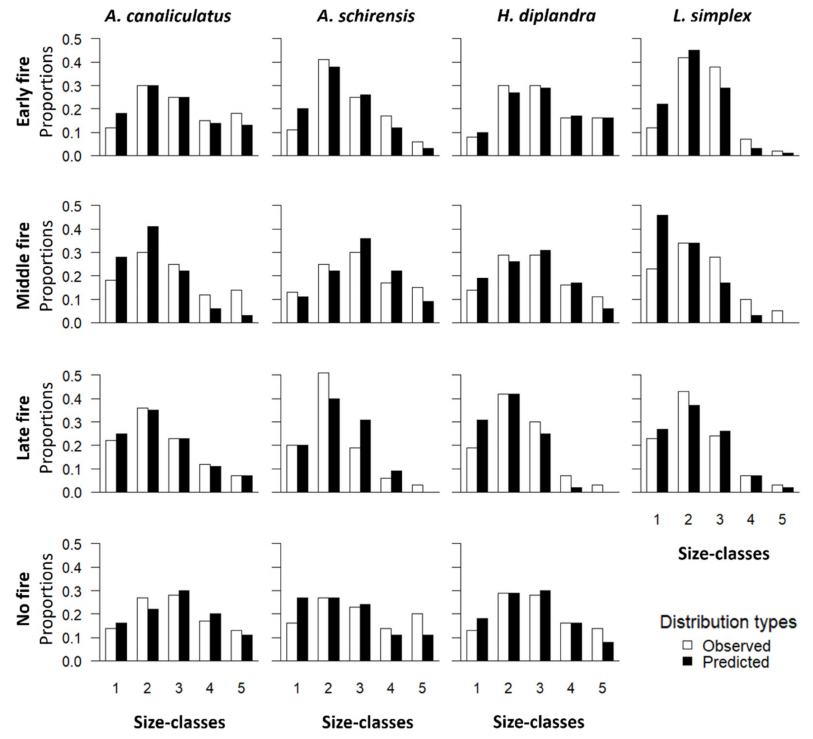
Figure 3. Comparison of observed and predicted distributions of individuals in size-classes for each combination of species (Andropogon canaliculatus , Andropogon schirensis , Hyparrhenia diplandra and Loudetia simplex ) and fire treatments. The predicted size distributions were calculated using the mean matrices over the four one-year